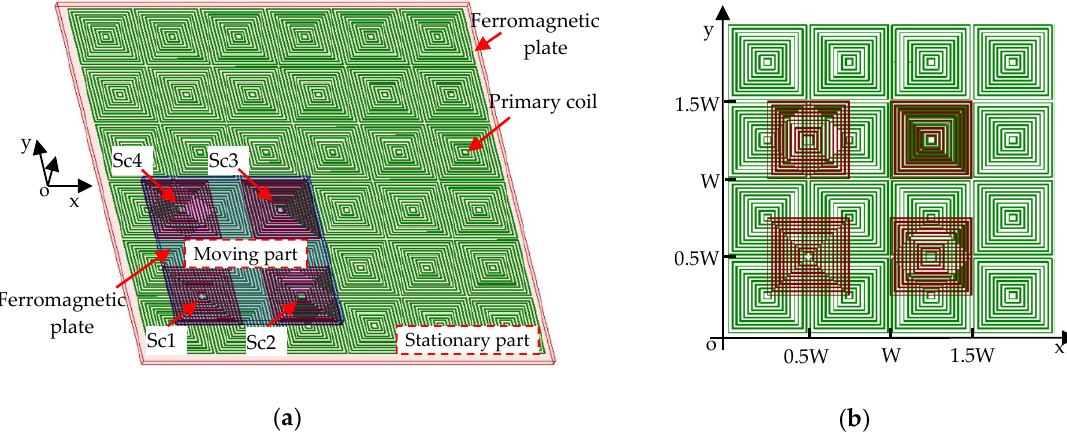
Figure 1. ( a ) Structure diagram of the 2Dsensor. ( b ) Arrangement of primary and secondary Figure 1. (a) Structure diagram of the 2Dsensor. (b) Arrangement of primary and secondary coil.